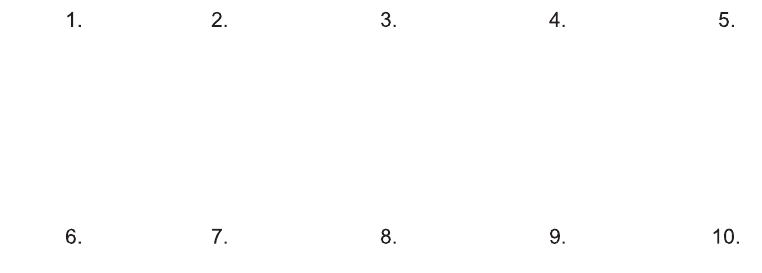
Figure 1. IOTN-AC score